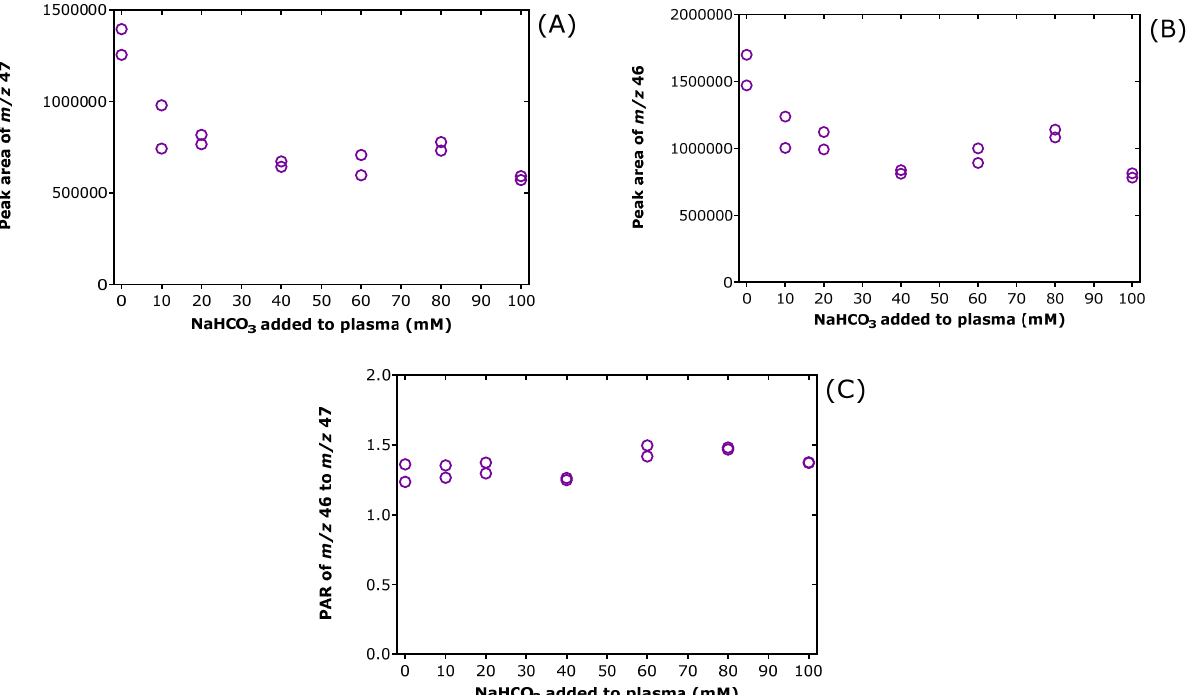
Figure 5. Plots of the peak area of ( A ) m / z 47 for exogenous nitrite (i.e., [ 15 N]nitrite, 1 µ M), of ( B ) m / z 46 for endogenous nitrite (i.e., [ 14 N]nitrite) in a human plasma sample spiked with the indicated bicarbonate concentrations, and of ( C ) the resulting peak area ratio (PAR) of m / z 46 to m / z 47 for nitrite. Data are shown from two independent experiments. The derivatization time with PFB-Br was 5 min each. No [ 15 N]nitrate was added to the plasma sample.